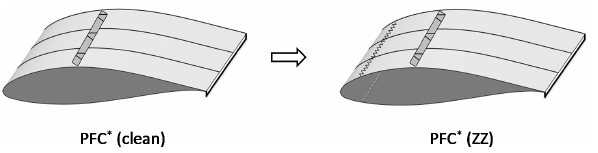
Figure 15. New design application of passive flow control devices on a generic rotor blade